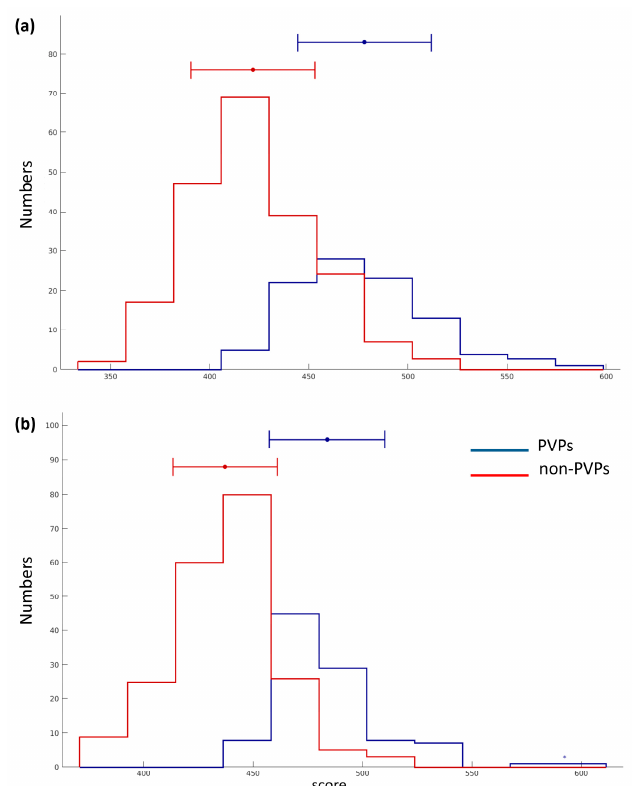
Figure 3. The histogram of scores of PVPs and non-PVPs derived from PVPred-SCM on the benchmark dataset by using initial ( a ) and optimized ( b ) dipeptide propensity scores, respectively.